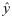
Proposed framework.(A) HC subjects with normal CSF profile are identified from cutoff values calculated from CSF biomarkers distributions. (B) Longitudinal ROIs of these subjects are modelled using LME approach, variant (vr) and quasi-variant (qvr) ROIs and Y-intercepts (y0) ROIs values are identified and then null models for both genders are built from these values by applying multivariate modelling. (C) qvr ROIs values of new HC, MCI and AD subjects are used within null models to infer the y0 values of vr ROIs. Estimated ROIs values (y^) at different ages are estimated by linear regression by using y0 and β coefficients of age and education. Residuals are calculated as the difference y-y^; and finally, SVM classifiers are trained for subject classification and addressing the early diagnosis problem: HC vs MCI, MCI vs. AD and HC vs AD. The full workflow of last two stages is applied separately for each gender.